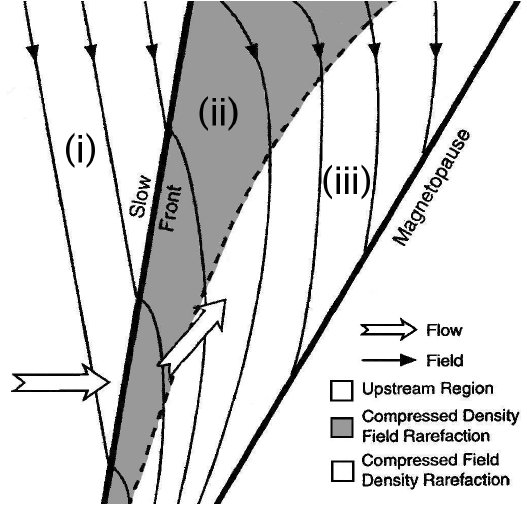
Fig. 2. A sketch of the basic structures of the subsolar magne- tosheath flow taken from Southwood and Kivelson (1995). In the figure, there are structures with large physical parameter variations occurring at the bow shock, the magnetopause, the plasma depletion layer, and the slow wave front. They are all constrained to limited regions. For the other parts that occupy most of the volume of the magnetosheath, smooth flow and field dominate. Region (iii) is the conventional plasma depletion